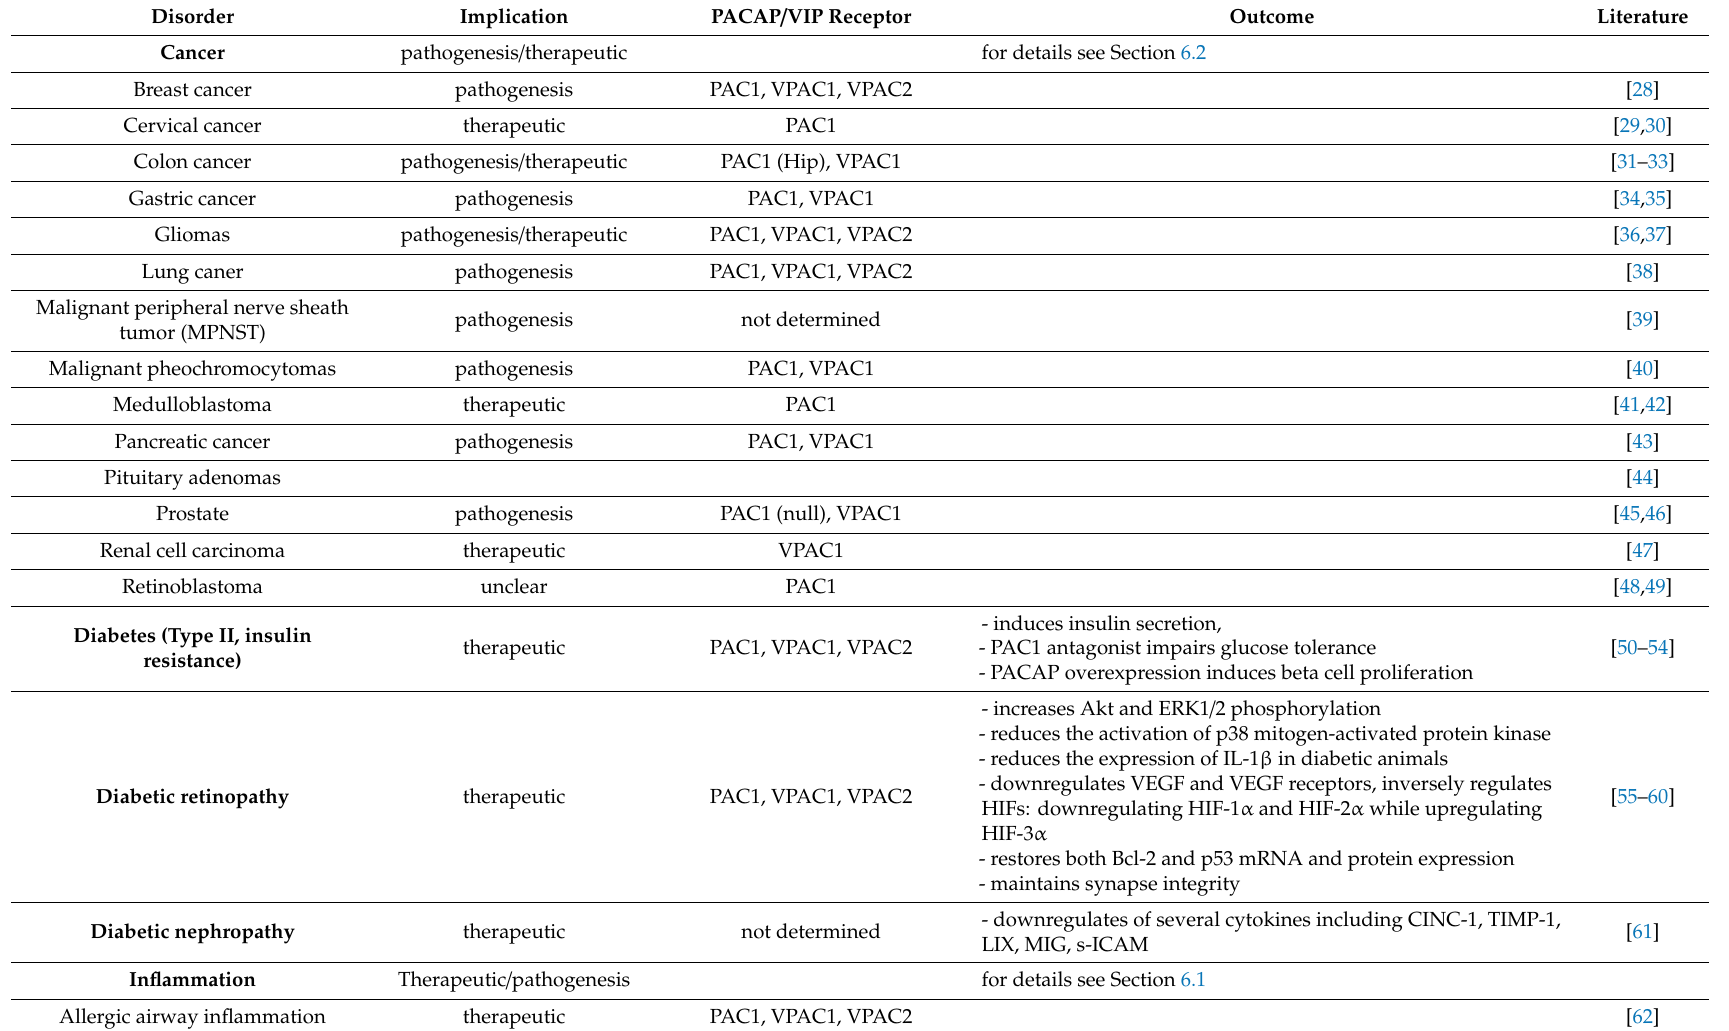
Table 1. Summary of the most relevant PACAP-related